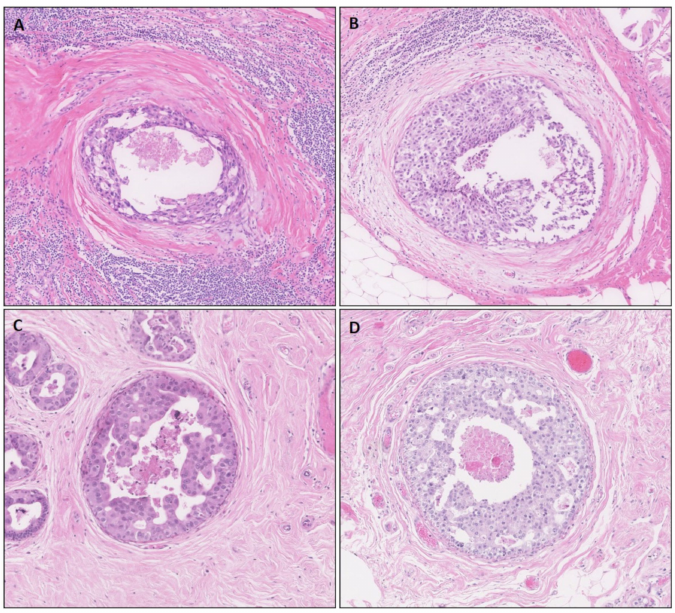
Figure 1. Histological representation of TIL-rich ( A , B ) DCIS. Neoplastic cells are surrounded by a TIL-poor area of reactive stroma and, subsequently, a zone of many TILs. ( C , D ) TIL-poor DCIS